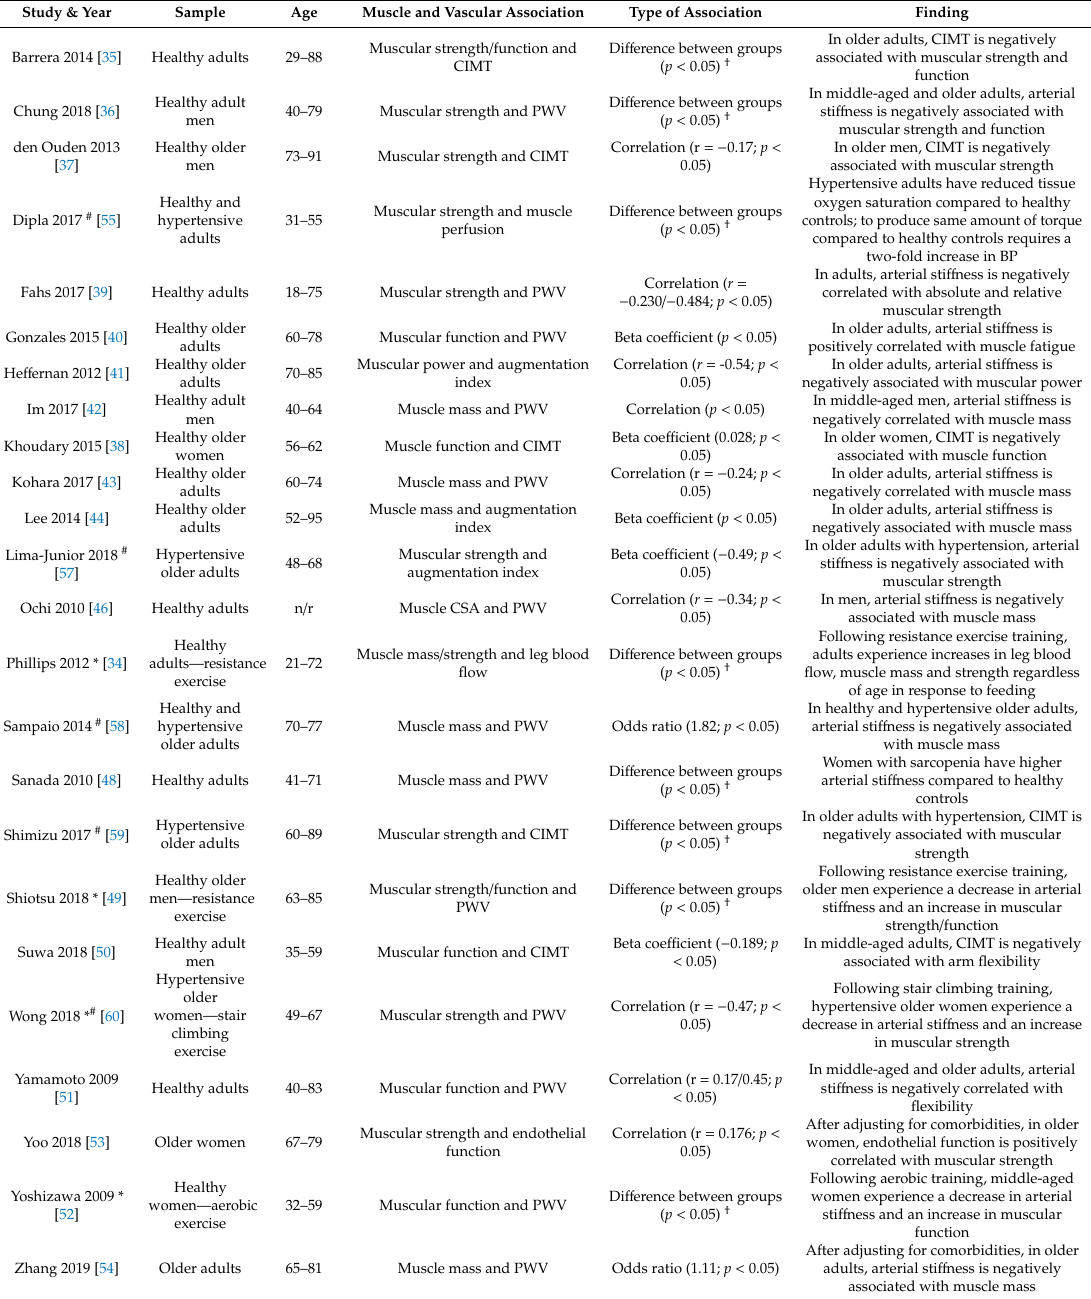
Table 4. Association between skeletal muscle and macrovascular blood